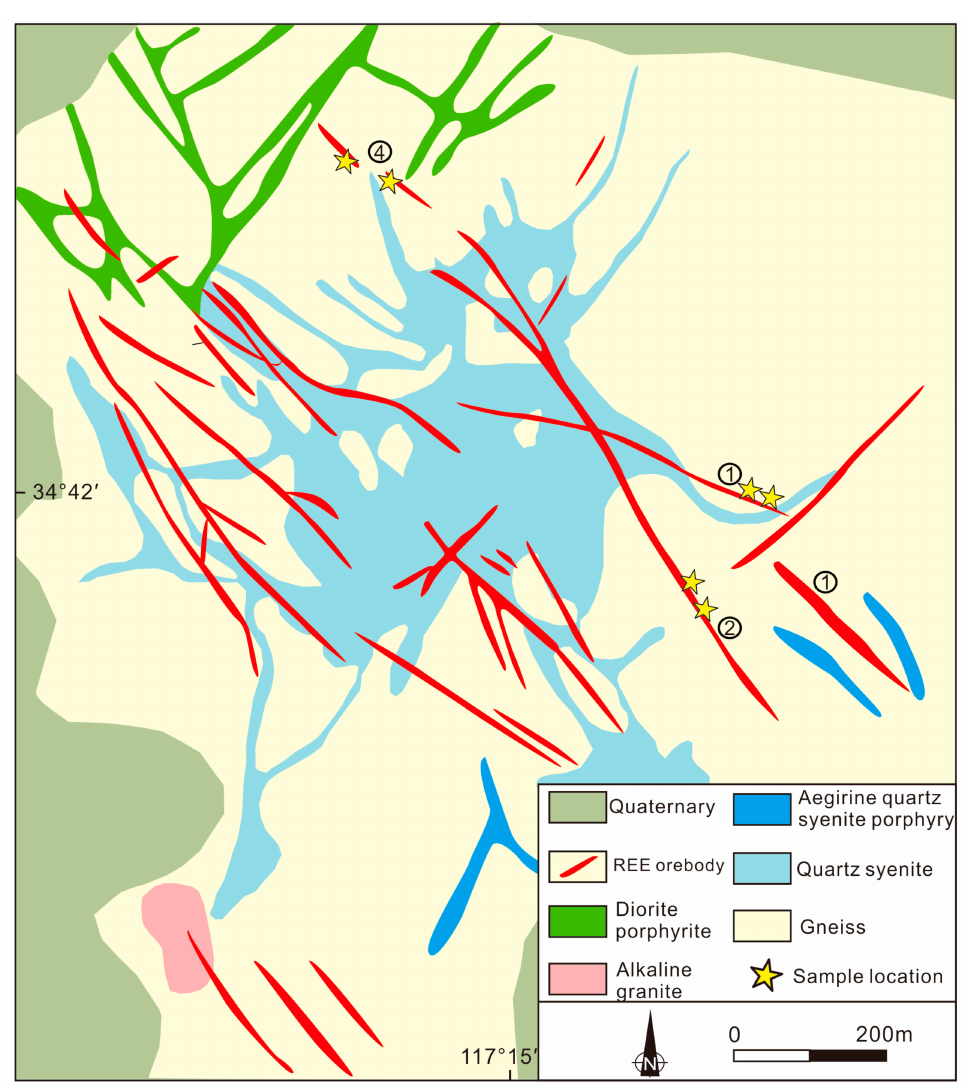
Figure 2. Geological sketch map of the Weishan rare earth element (REE) deposit in Shandong Province (modified from reference